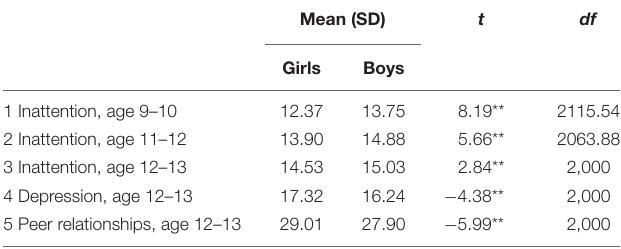
TABLE 3 | Results of t -test about sex difference (Panel 1).